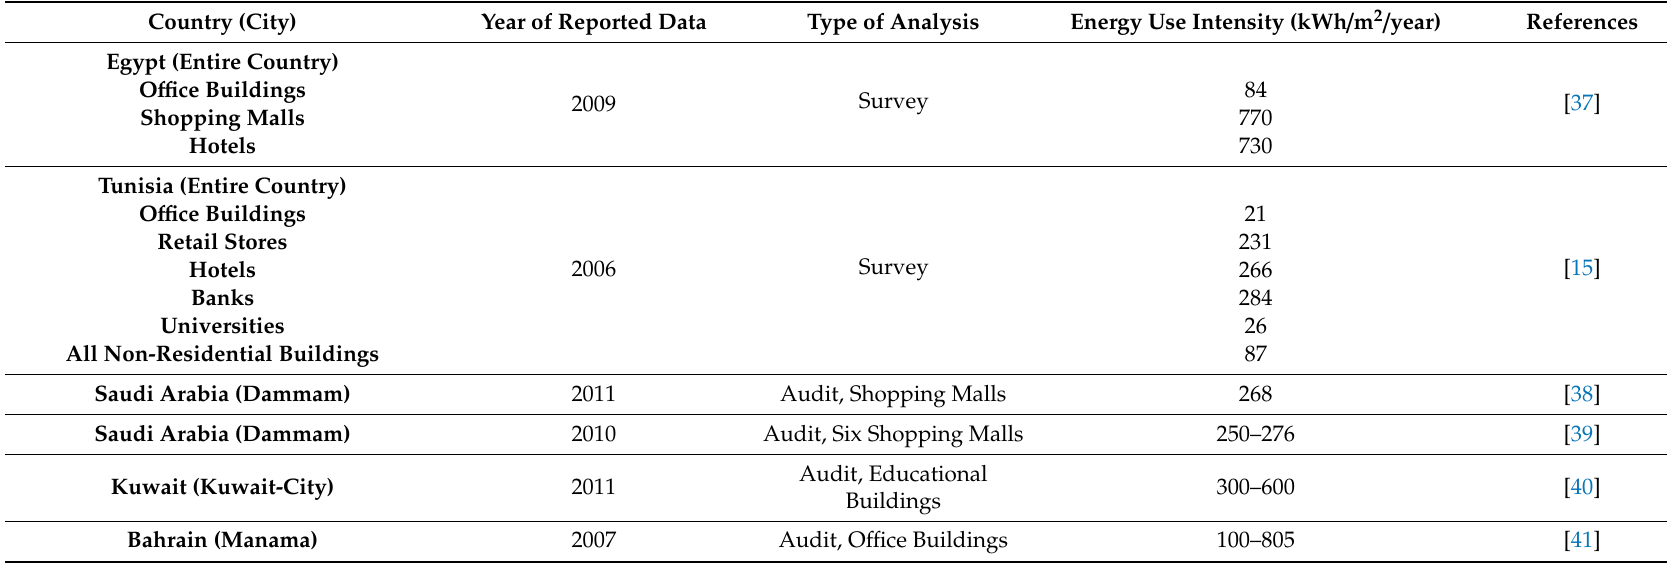
Table 12. Reported EUI values for non-residential buildings in select Arab